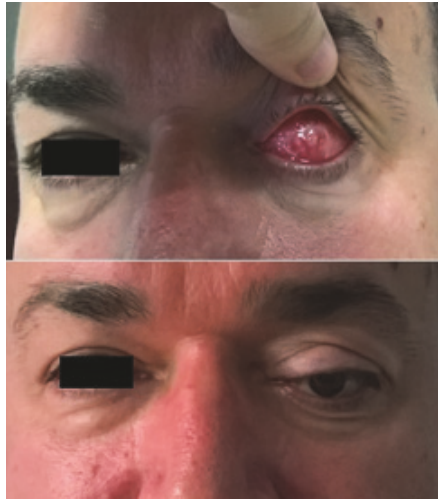
Figure 1: 50-year-old Caucasian male patient 4 years after the procedure.